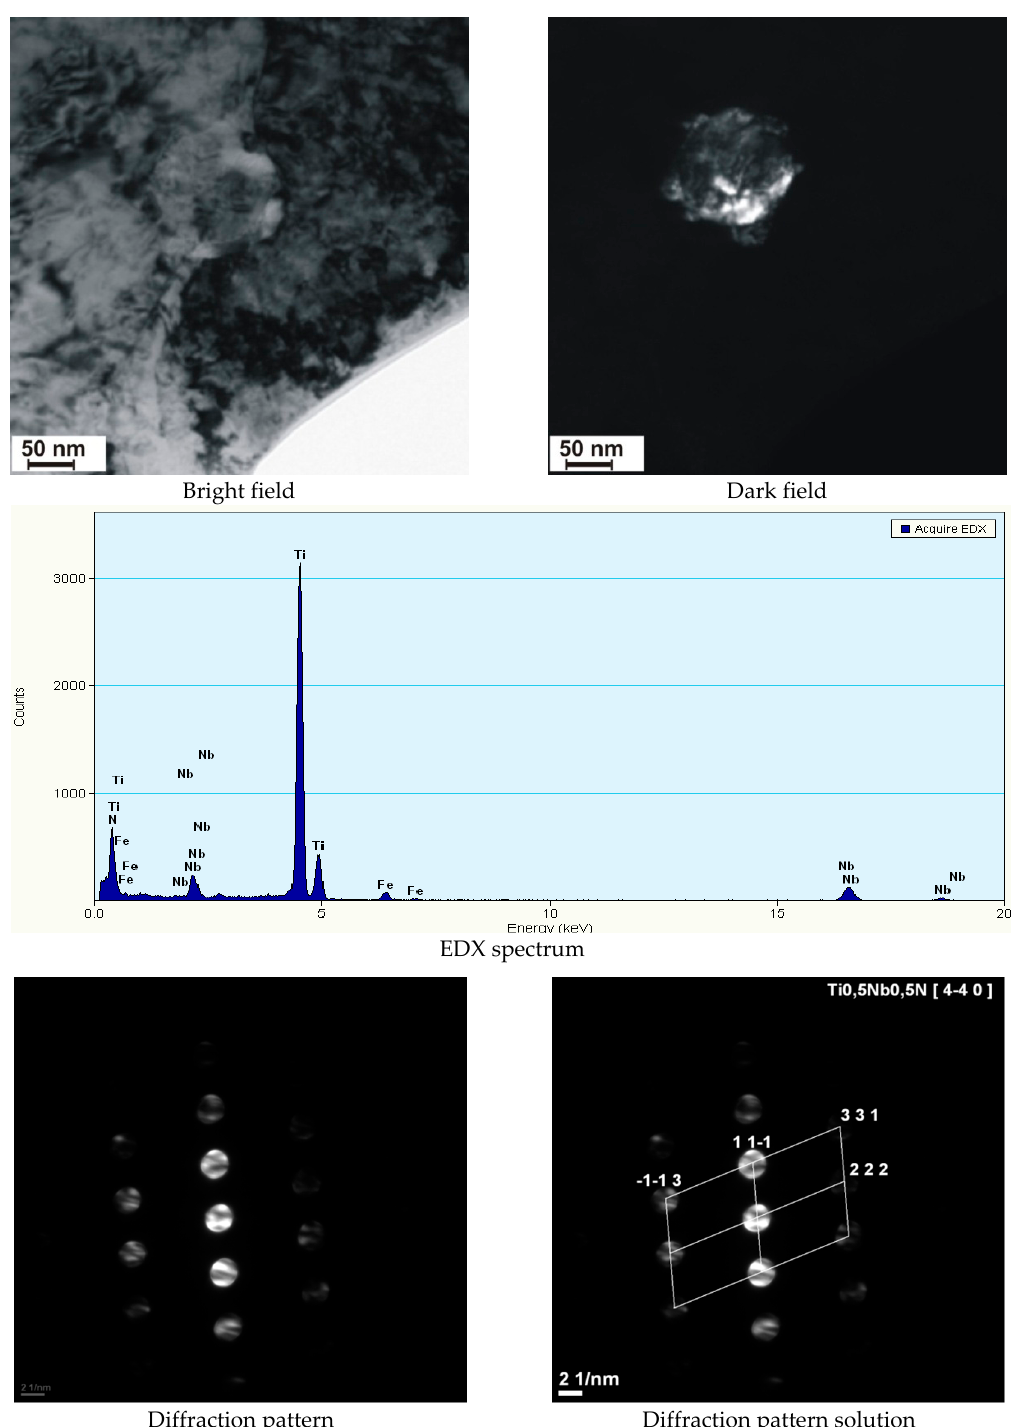
Figure 12. Precipitation of nitride (Ti,Nb)N along with a number of spherical precipitates with high dispersion of dislocations in a plastically deformed matrix surrounding the HAZ of steel S700MC; the welding process was performed using the TIG method and a linear energy of 30 kJ/cm.